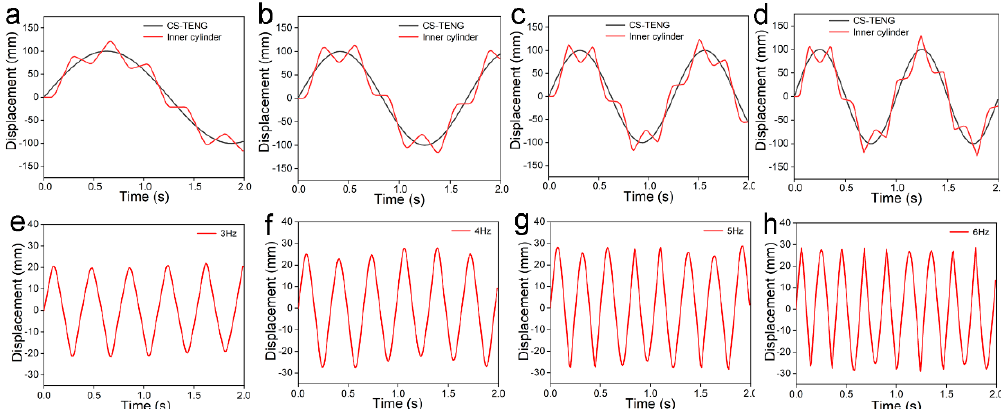
Figure 6. Finite element analysis of the CS-TENGs using ANSYS: ( a – d ) motion trajectories of the CS-TENG devices and the inner cylinder, and ( e – h ) the normalized displacement of the inner cylinder when the CS-TENGs were operated under frequencies of 3 Hz, 4 Hz, 5 Hz, and 6 Hz, respectively.